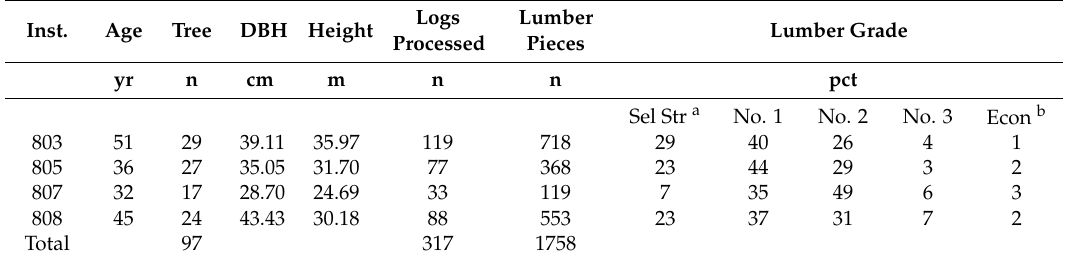
Table 3. Sample data and percent volume yield by lumber grade of the sampled installations. Inst. DBH